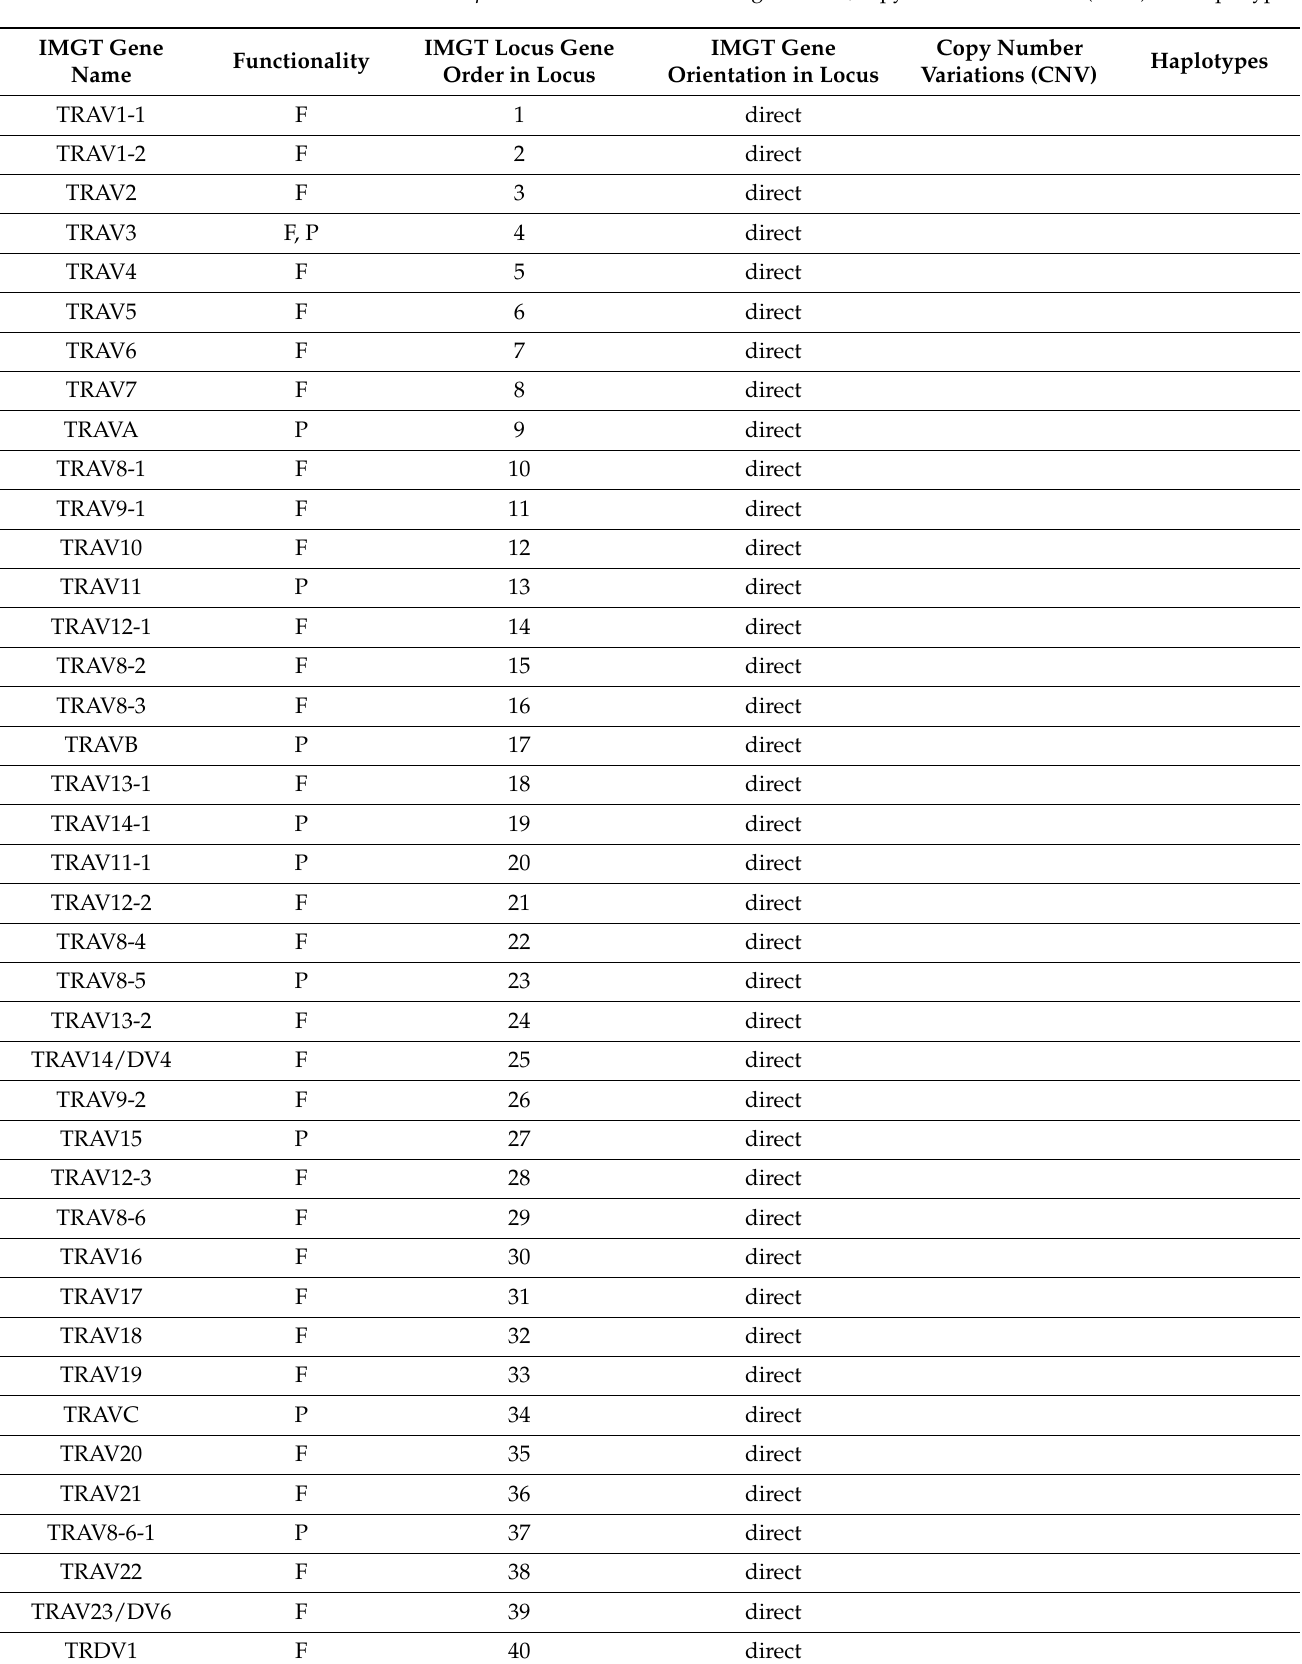
Table 8. Homo sapiens TRA/TRD locus: IMGT gene order, copy number variations (CNV) and haplotypes. IMGT